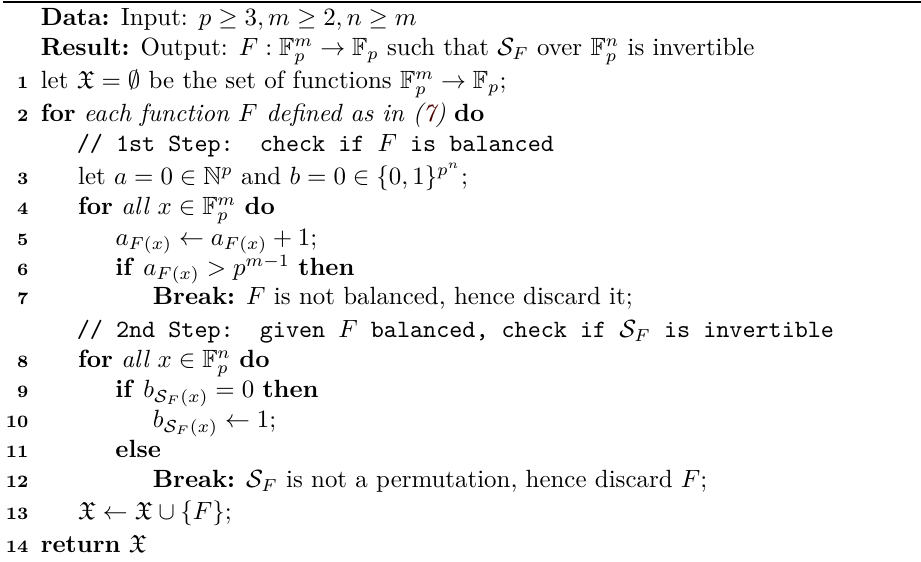
over F n is F p